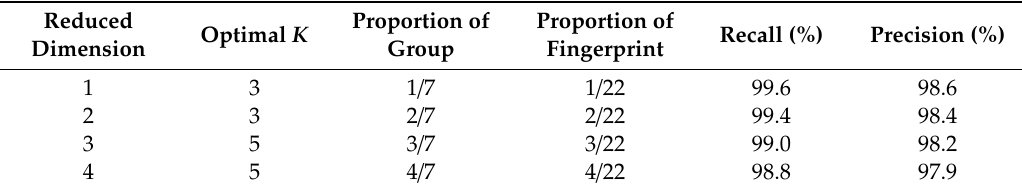
Table 3. Horizontal dimensionality reduction results.